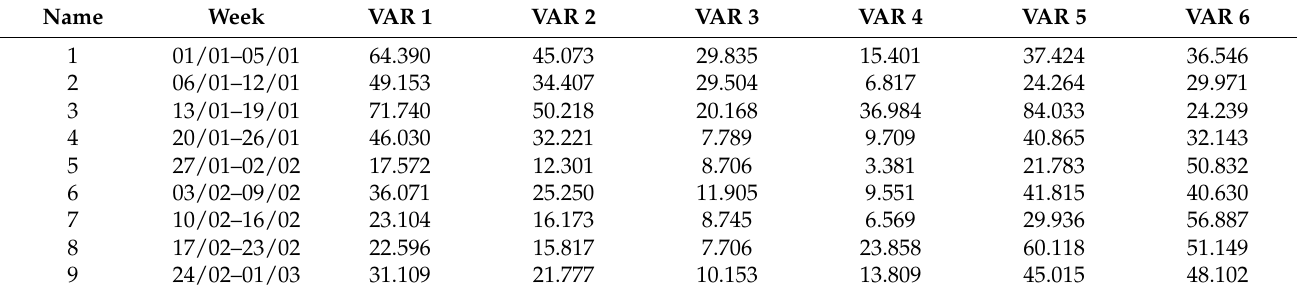
Table 2. Summary (weekly average values) of the concentration of PM 10 ( µ g/m 3 ) and PM 2.5 ( µ g/m 3 ) and the content of SO 2 ( µ g/m 3 ), NO ( µ g/m 3 ), NO x ( µ g/m 3 ) and O 3 ( µ g/m 3 )—“winter